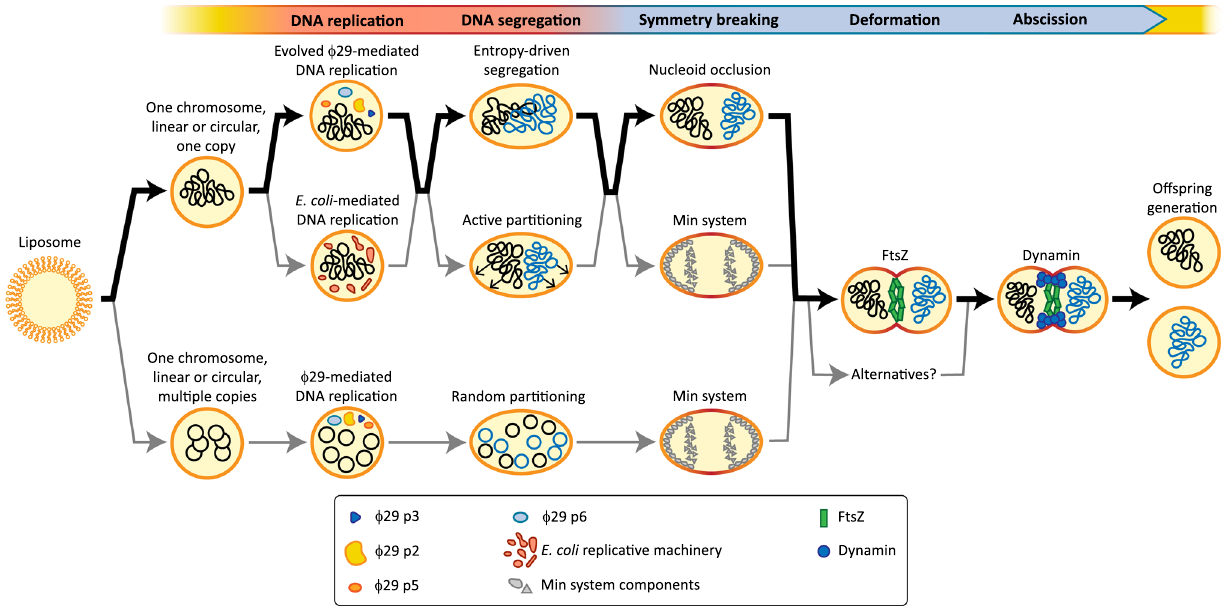
Fig. 6 Towards a synthetic cell cycle. Various possible routes are indicated to accomplish a sustainable synthetic cell cycle. The pathway that, in our opinion, is most promising based on current insights, is marked in bold black arrows. Alternative paths are depicted in thin grey arrows. Note that not all possible alternative paths are displayed and that we only depicted circular chromosomes here. However, a linear chromosome architecture could also be a viable option, especially in combination with the φ 29